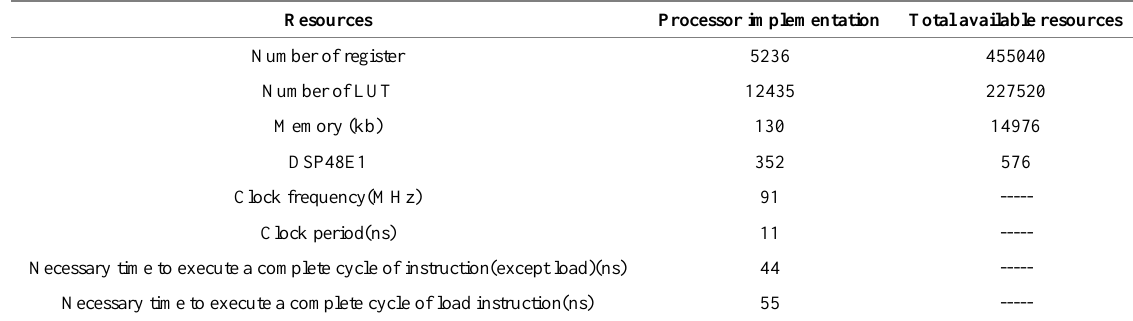
Table 2. Consuming table and total available sources of FPGA.